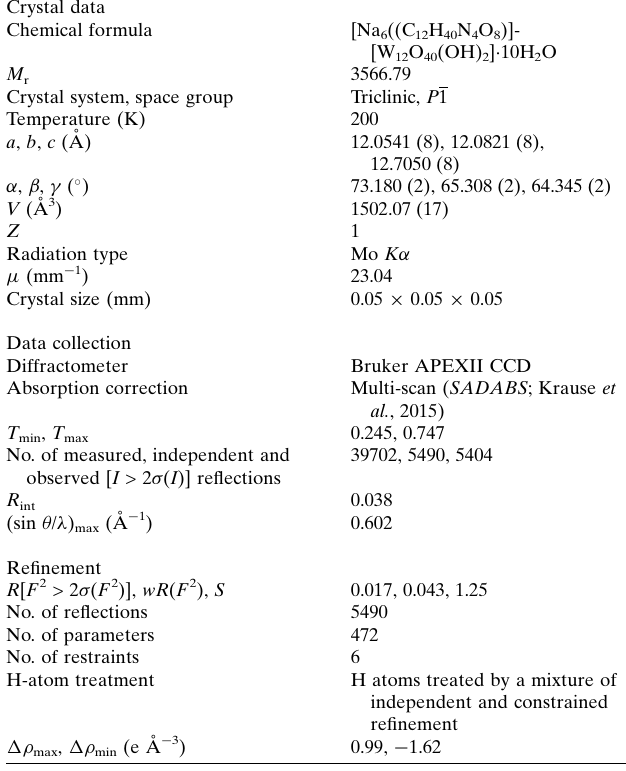
Table 2 Experimental details. Crystal data Chemical